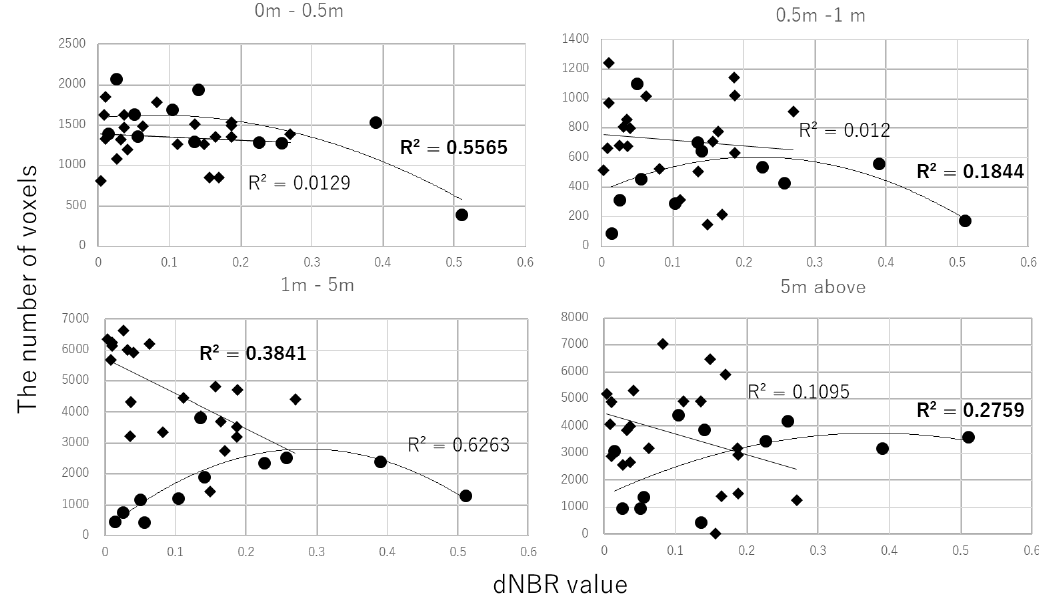
Figure 5. The relationship between dNBR and the number of voxels at different heights or strata (marker ● : recently burned plot, ♦ : unburned plot, the bold fonts of R 2 values are statistically significant for the linear case and not-significant for the non-linear case with a significant level of 0.05).